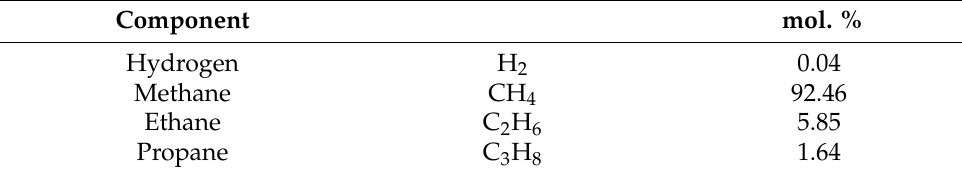
Table 3. Fuel gas